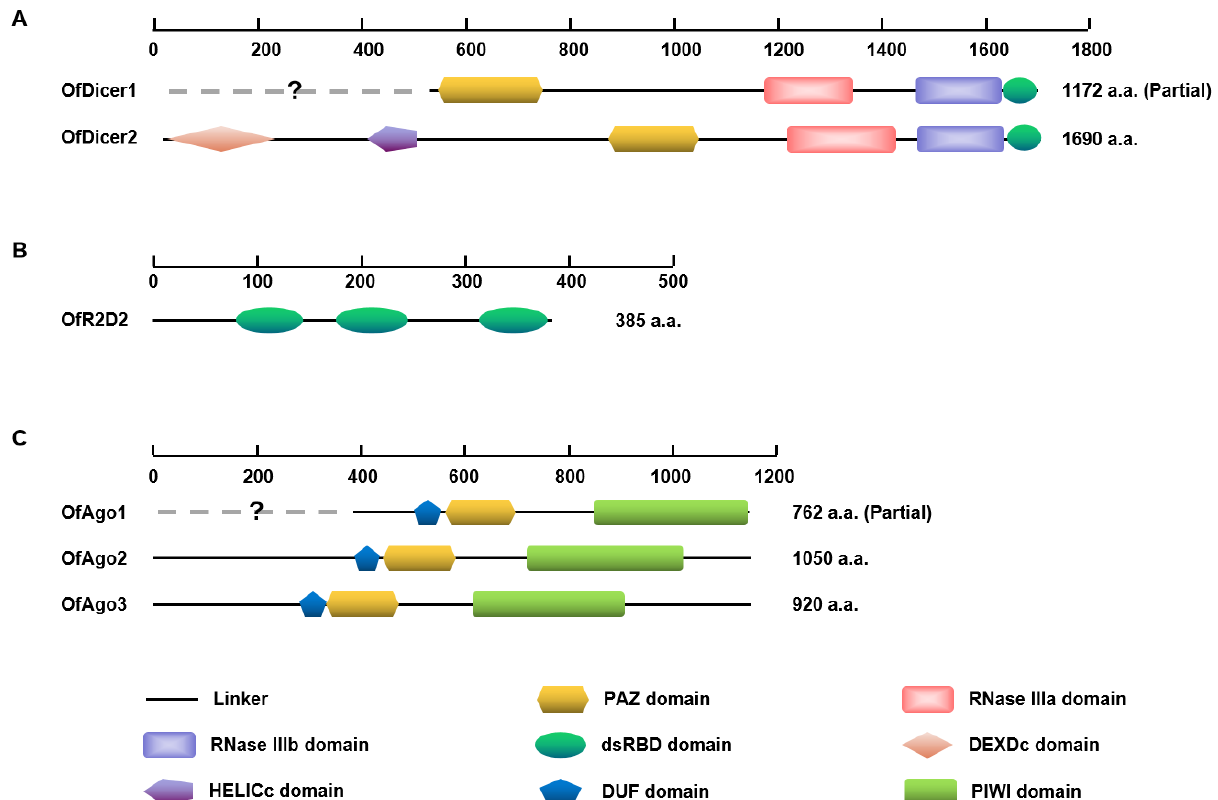
RNase III domains play central roles in excising siRNAs preferentially from ends of dsRNA molecules in Dicer proteins. The function of dsRBD is to bind dsRNA [29].